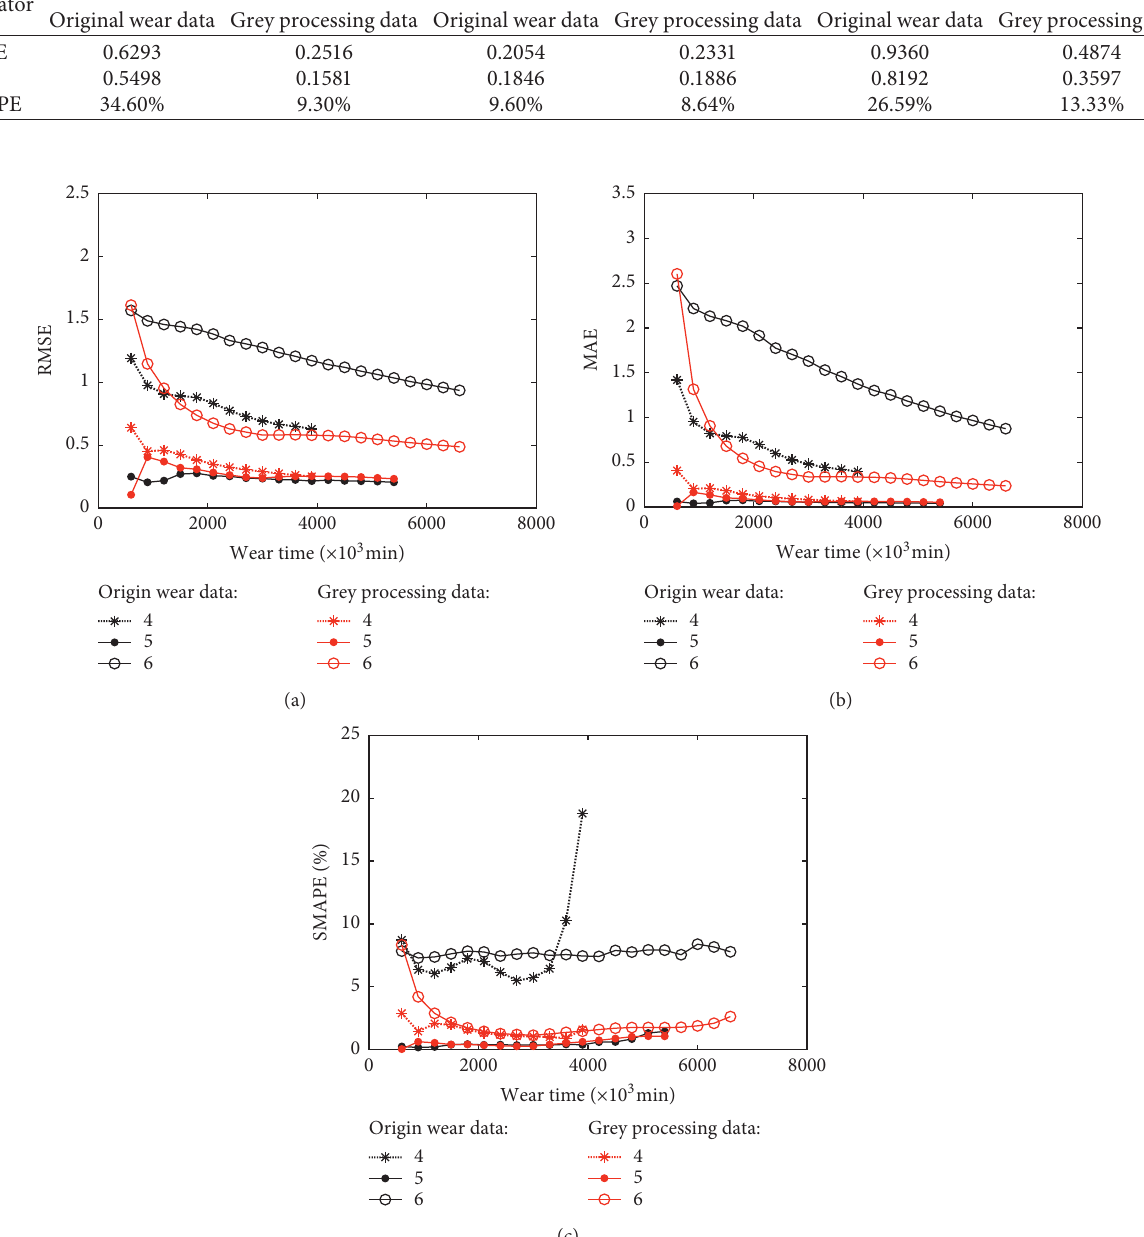
Figure 8: RMSE MAE and SMAPE of predicted RUL values. (a) RMSE. (b) MAE. (c)